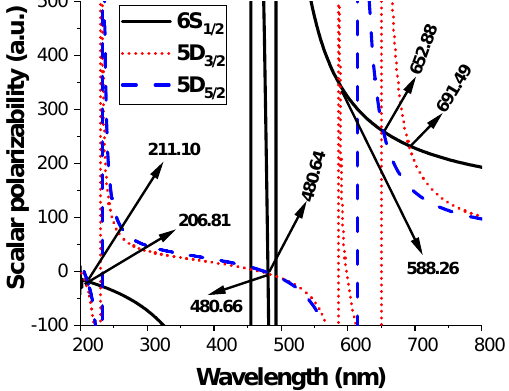
Figure 2. Scalar dynamic polarizabilities of 6 2 S 1 n 2 L J states are indicated by nL J . The positions of the crossing points between the polarizability v v curves for 6 2 S 1 and 5 2 D 3 states provide the values of wavelengths (indicated in the panels in 5 2 , 2 2 the unit of nm), which yield zero differential scalar polarizabilities for the 6 2 S 1